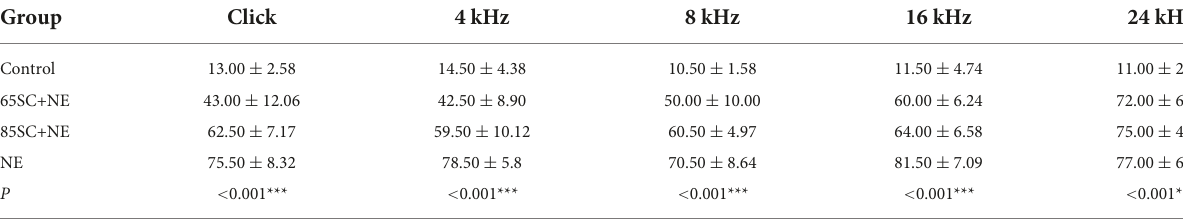
TABLE 2 Auditory brainstem response (ABR) thresholds of each group at the moment of noise exposure (D0) (dB SPL). Group Click